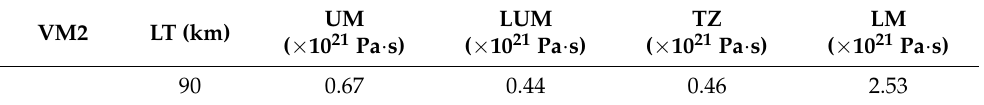
Table 3. Parameters of the four-layer mantle discretization; Litosheric Thickness (LT), Upper Mantle (UM), Lower Upper Mantle (LUM), Transition zone (TZ), and Lower Mantle (LM).